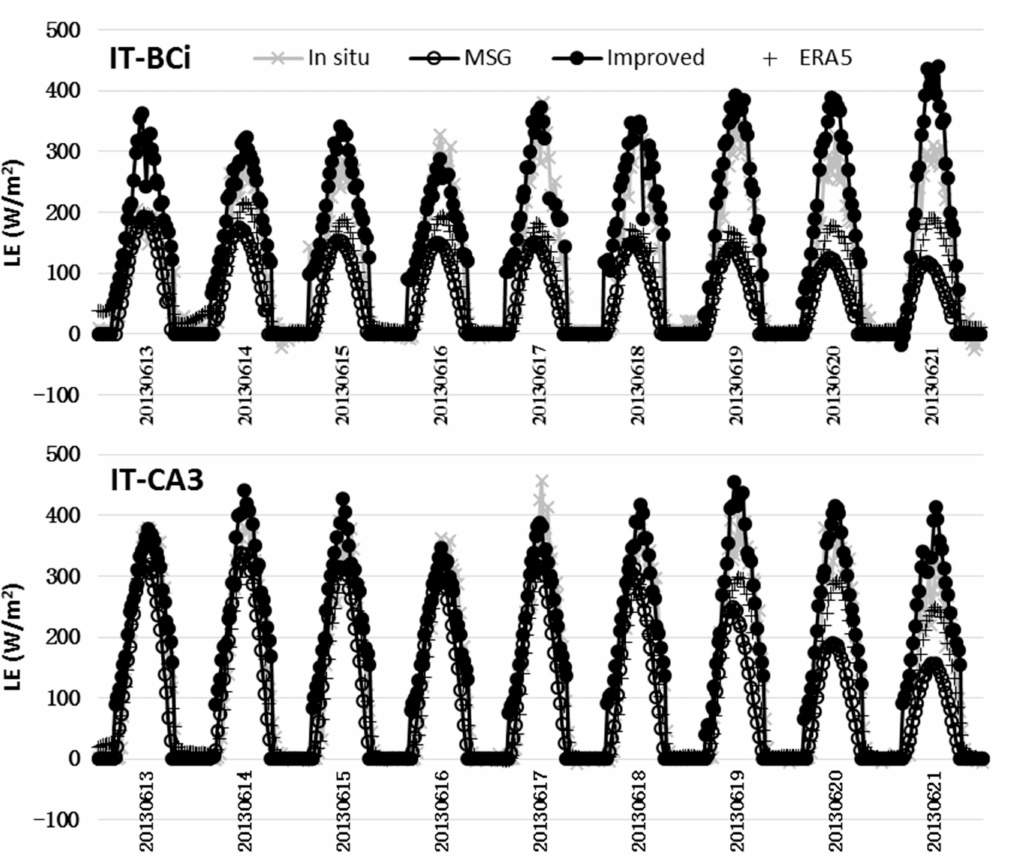
Figure 5. Diurnal LE variation from improved scheme, MET product, ERA5 ET data, and in situ measurements from FLUXNET2015 during nine consecutive days for two flux